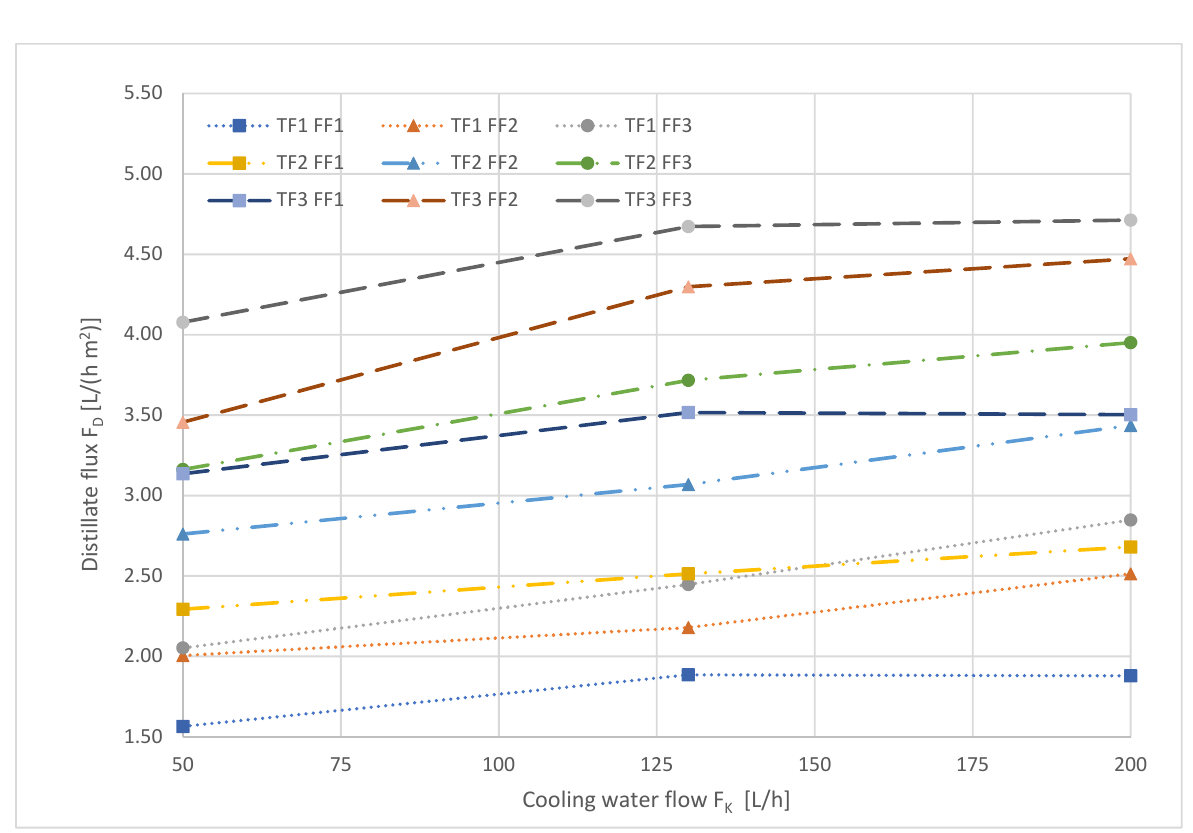
Figure 6. Distillate flux as a function of the cooling water flow. The numbers refer to the different levels, low (1), medium (2), and high (3), described in Table 4.